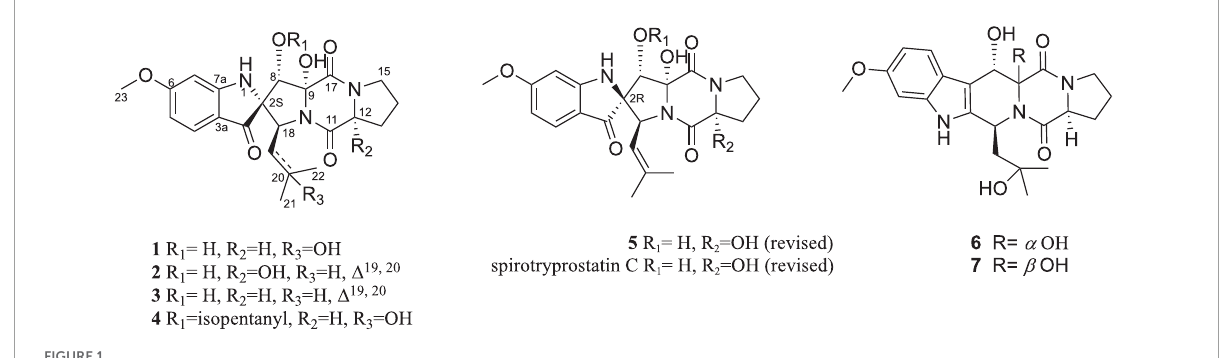
FIGURE1 Compounds 1–7 isolated and identified from Penicillium brefeldianum and revised structures of compounds 5 and spirotryprostatin